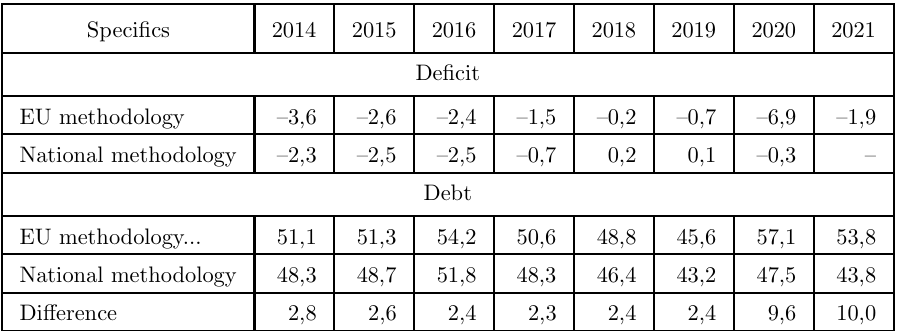
Table 5 Public sector deficit and debt in Poland according to national and EU methodology in relation to GDP in % from 2014 to